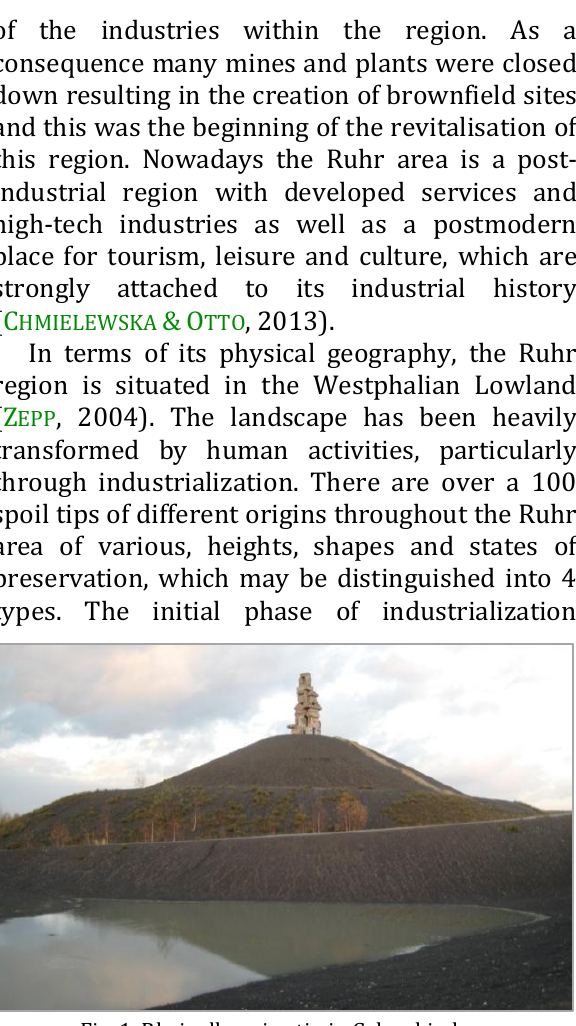
Fig. 2. Steps and footpath on the Schurenbach tip ( M. Chmielewska,